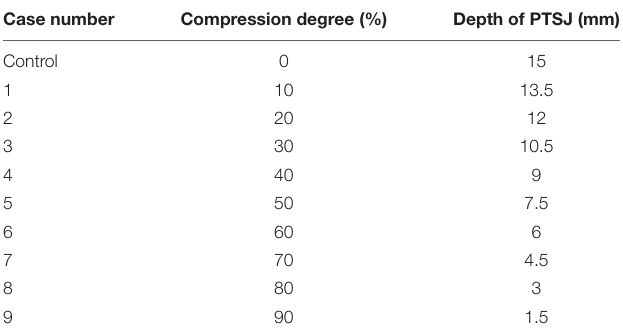
TABLE 1 | Cases with different compression degrees and the depth of blood vessels after